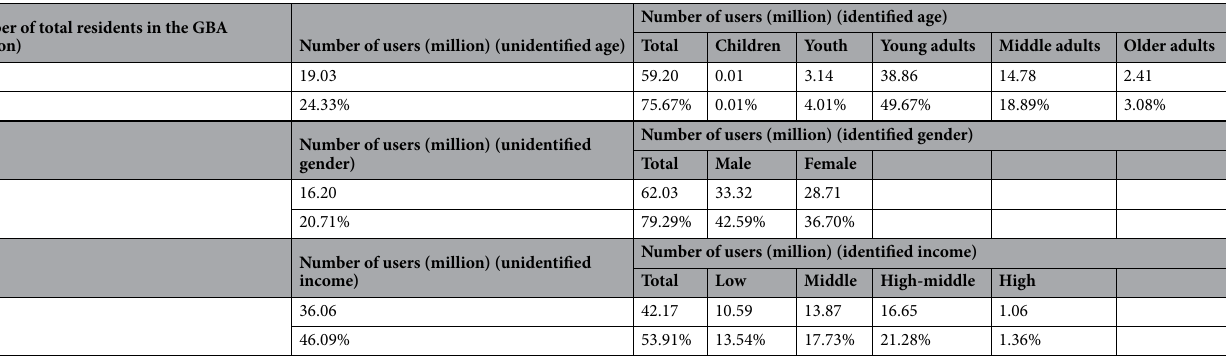
Table 1. Descriptive characteristics of the sample